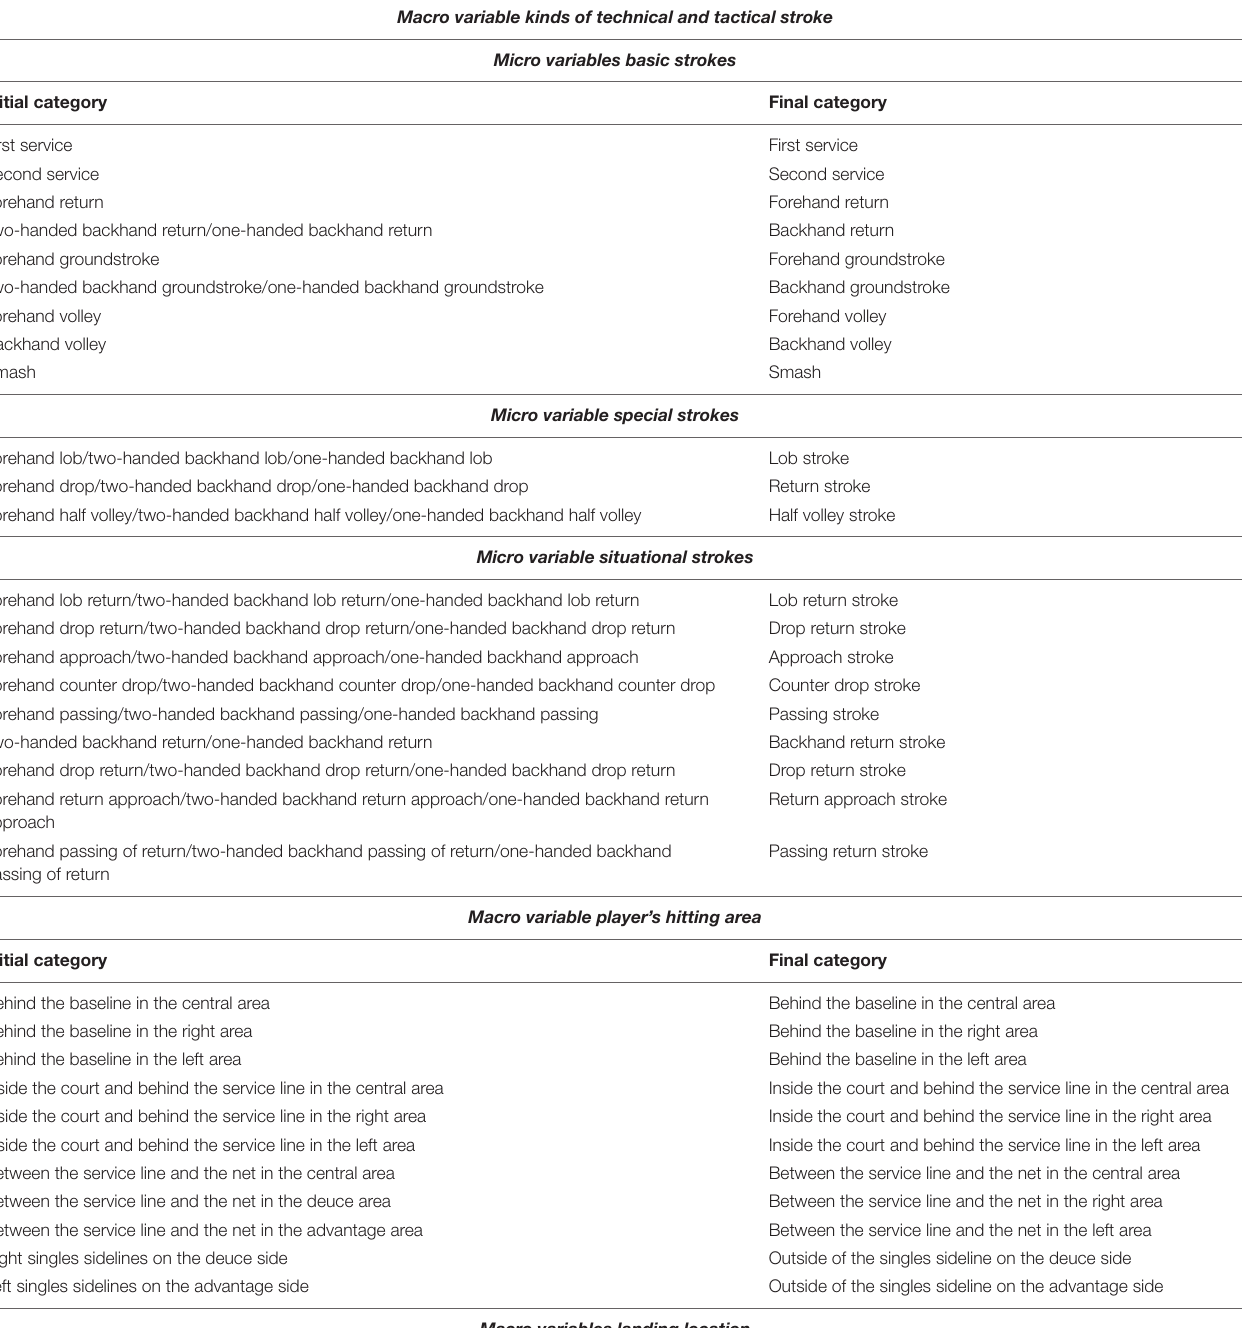
TABLE 1 | Macro variables, micro variables, and initial category of the observational instrument (initial category) and their final transformation for this study (final